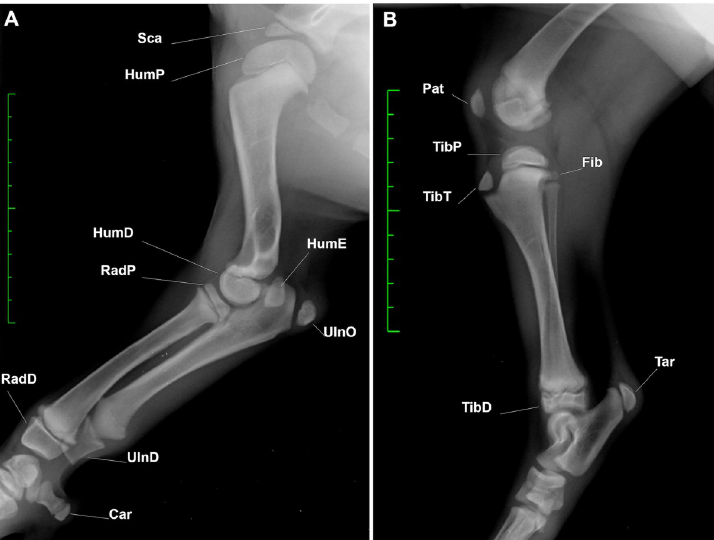
Fig 1. Radiographic appearance of the examined ossification centres. A. Saarloos Wolfdog, F, 6 weeks; medio- lateral view of the right forelimb; B. Saarloos Wolfdog, F, 8 weeks; medio-lateral view of the right hindlimb. Green scale bar: Distance between two hyphens is of 1 cm. Abbreviations: Sca = supraglenoid tubercule; HumP = proximal epiphysis of the humerus; HumE = epiphysis of medial epicondyle of the humerus; HumD = distal epiphysis of the humerus; RadP = proximal epiphysis of the radius; RadD = distal epiphysis of the radius; UlnO = olecranon tuber; UlnD = distal epiphysis of the ulna; Car = accessory carpal bone; Fem = distal epiphysis of the femur; Pat = patella; Fab = Fabellae; Pop = Popliteal bones; Fib = proximal epiphysis of the fibula; TibP = condyles of the proximal epiphysis of the tibia; TibT = tibial tuberosity; TibD = distal epiphysis of the tibia; Tar = calcaneal tuber.